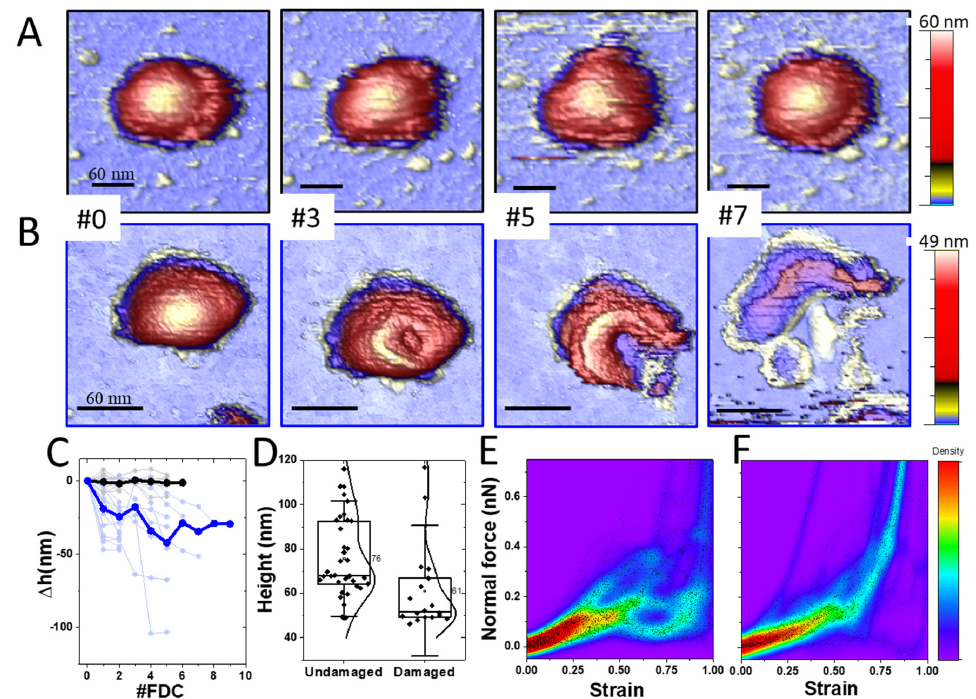
Figure 2. Mechanical characterization of TGEV particles. ( A , B ) Topographical images of TGEV virions after consecutive indentations. Particles can be classified in two groups: indentation resistive (( A ), Video S2) and indentation sensitive (( B ), Video S3) as shown in the topo images. Frame number indicates how many indentations were performed so far ( C ). Chart evolution of ∆ height as a function of the indentation number (FDC#). The values of height are taken from the indented region ( D ). Height plot distribution of particles before the indentation experiments, which agrees with the scale bars of ( A , B , E , F ). The heat map displays all the density of pixels for all the force-distance curves (FDC) of all particles as a function of the strain (Figure S2) for the indentation-resistive ( E ) and the indentation-sensitive ( F ) particles. Reddish colors mean more density of points which points to the coincidence of many experiments.